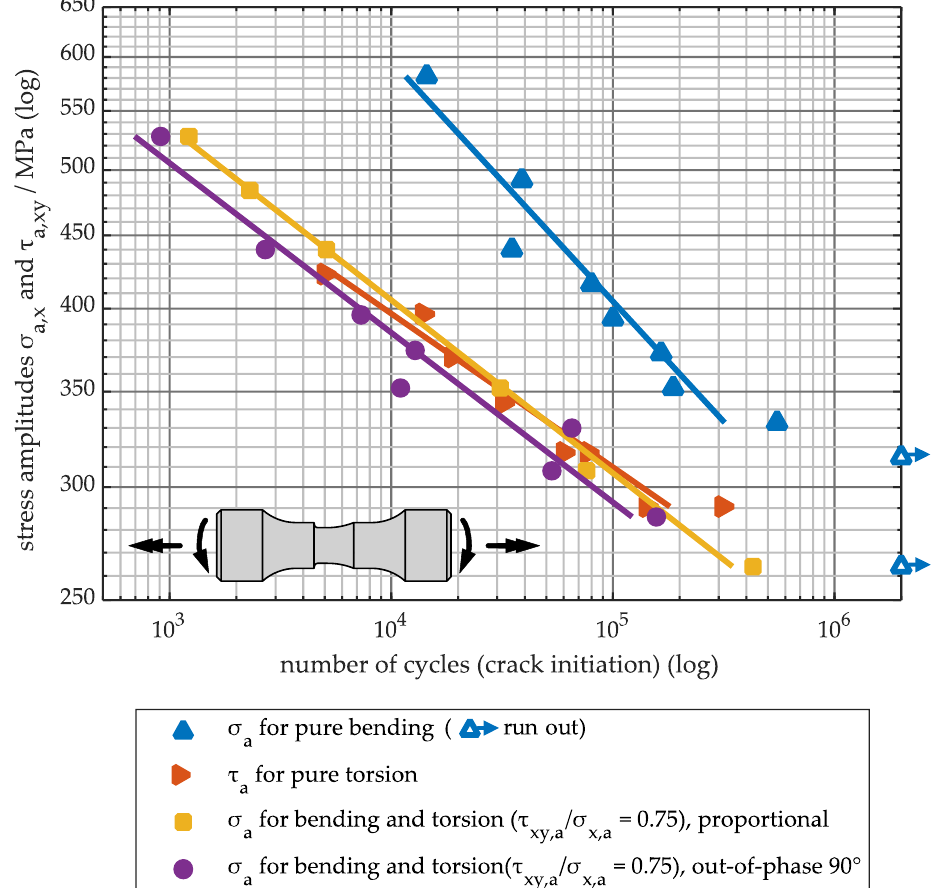
Figure 12. S–N curves for load-controlled tests on notched specimens, with amplitudes of local linear elastic stress components. Table 3. Cyclic properties according to Ramberg and Osgood for uniaxial and nonproportional (90° phase shift) loading.